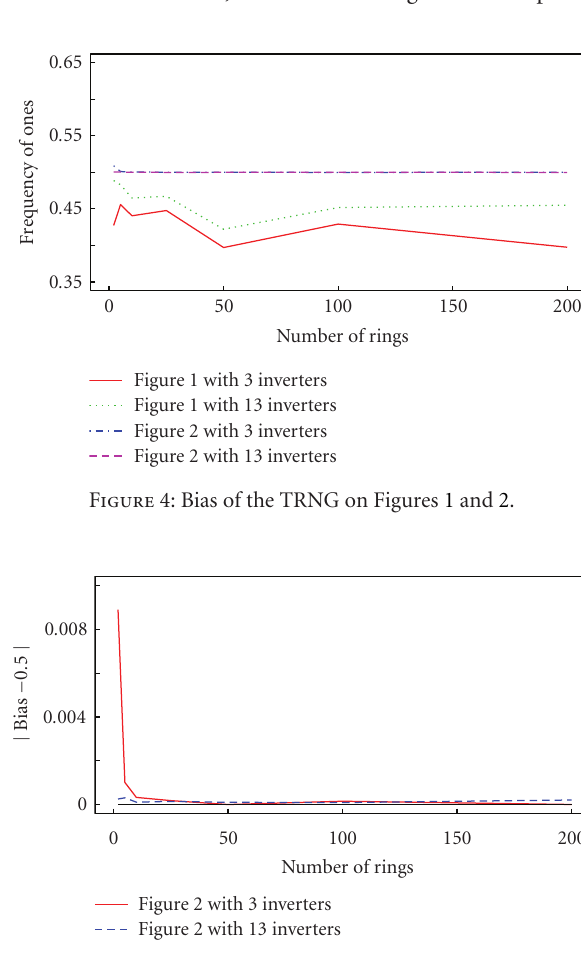
Figure 5: | Bias − 1 / 2 | of the TRNG on Figure